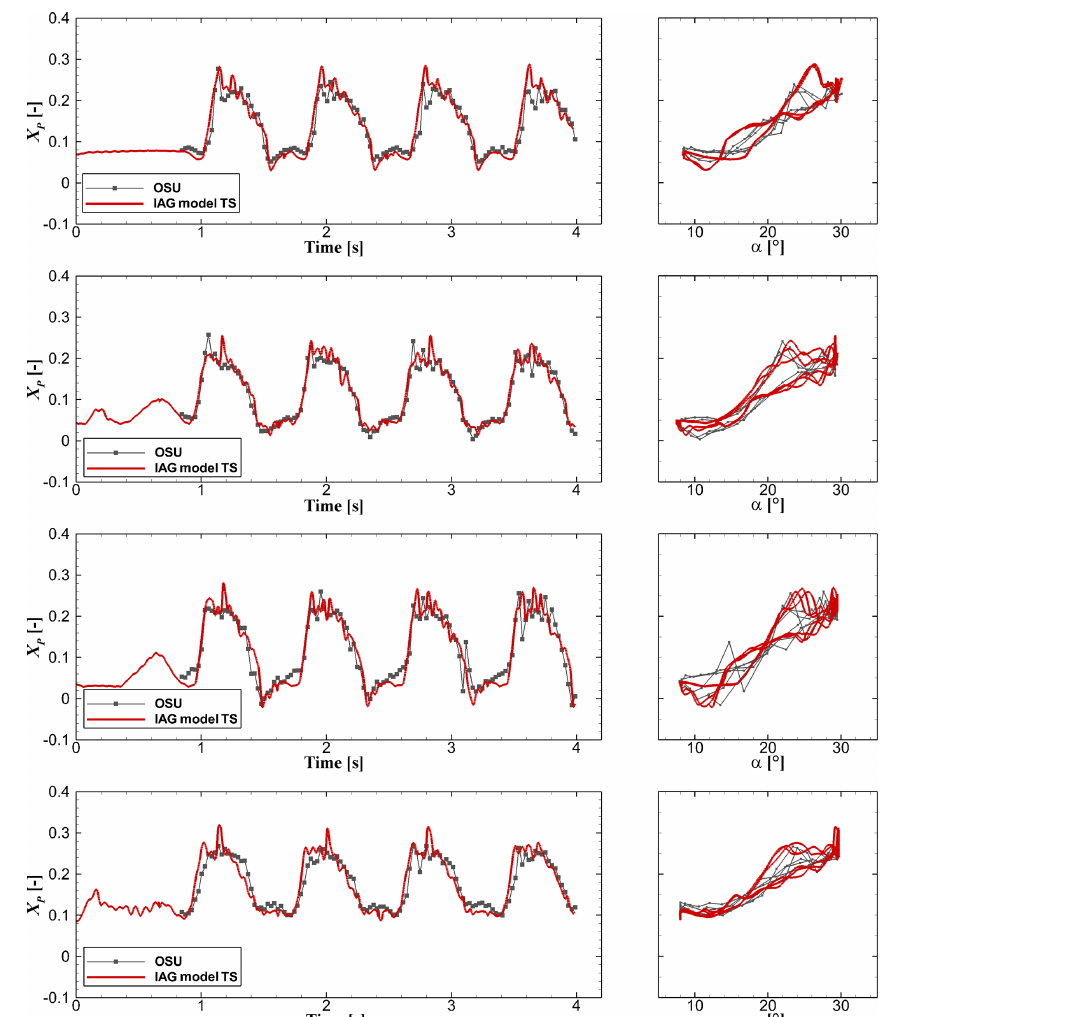
Figure 26. Center of pressure reconstruction in comparison with the measurement data by the IAG model for (cid:49)t = T/ 1440 using the actual angle of attack in the experimental campaign for different airfoils. From top to bottom: S801 (13.5%), NACA4415 (15%), S809 (21%) and S814 (24%). k = 0 . 073, α = 2 ◦ 0 and (cid:49)α = 10 ◦